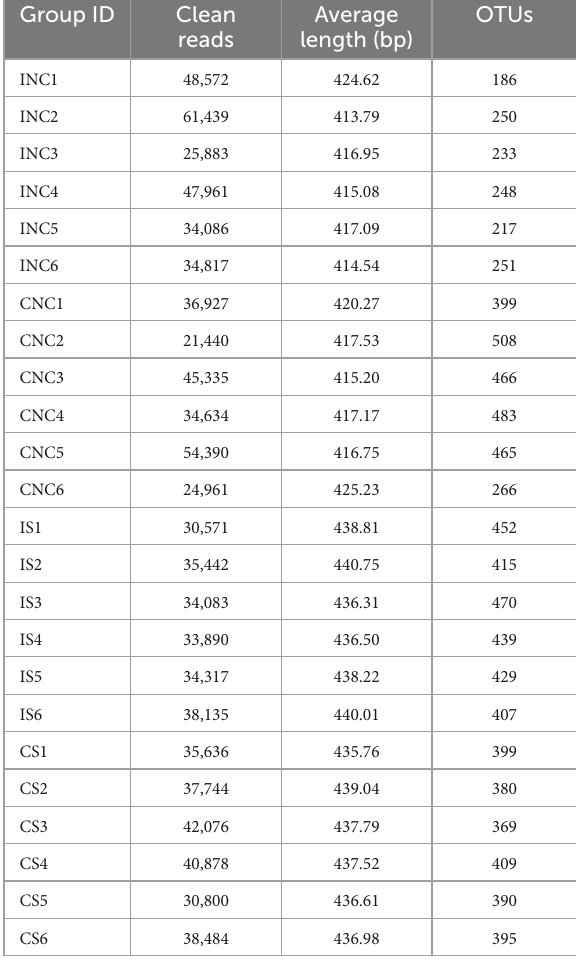
FIGURE2 Effects of 0.2% sodium butyrate on the relative mRNA expressions of the ileal barrier functional gene. Bate-actin was used as an internal standard for normalization. Values are means ± SEM for three independent biological and technical replications, n = 6. * P < 0.05. CLDN1, claudin-1; MUC1, mucin-1; OCLD, occludin; ITGB1, β 1 integrin; COL, collagen; PKC, protein kinase C.